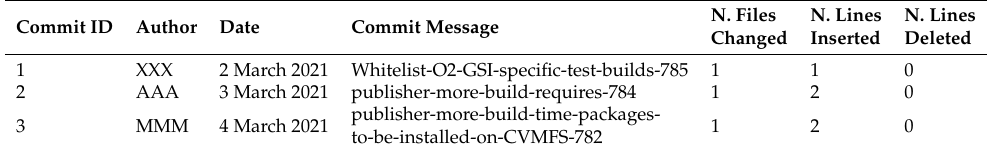
Table 2. Structured dataset